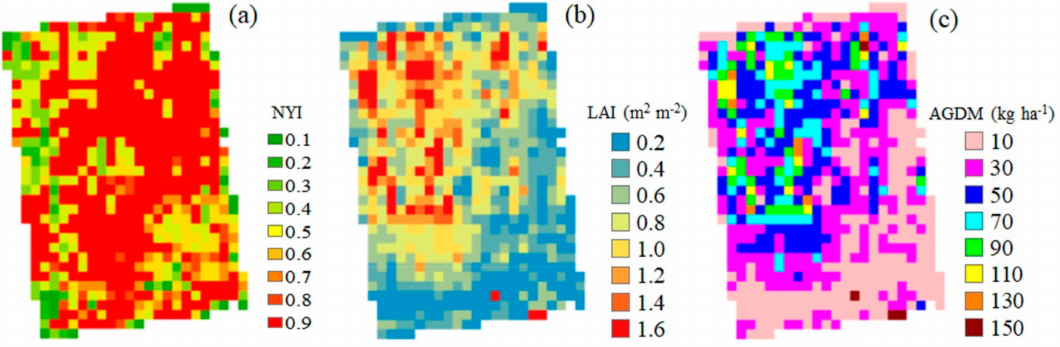
Figure 8. Two-dimensional field variations in the simulated barley variables of normalized yield index, NYI ( a ), leaf area index, LAI ( b ), and above ground dry mass, AGDM ( c ) at 60 days after rejuvenation